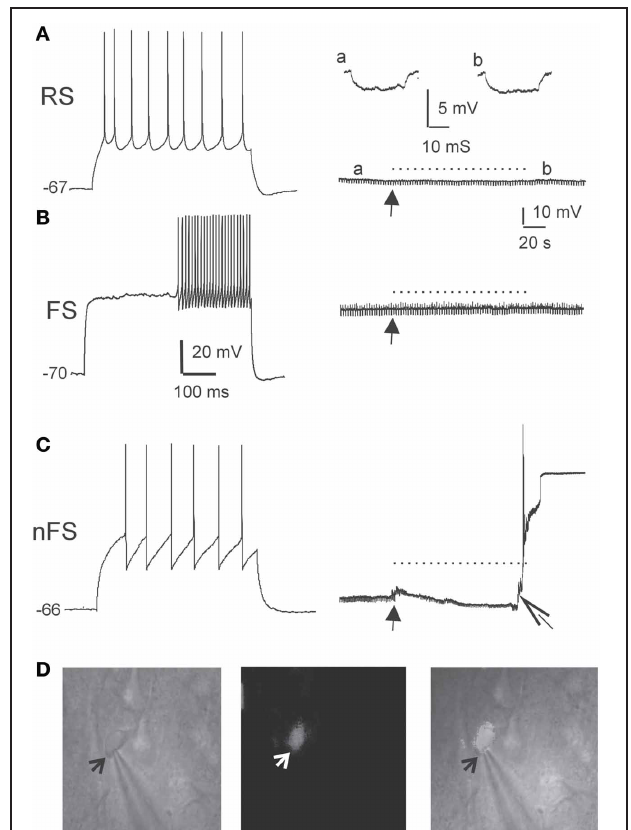
FIGURE 3 | DAF phototoxicity is selective to interneurons with LTS firing pattern. Layer 5 neurons were recorded in slices pre-incubated in DAF-2DA (2 μ M, 10min). (A) The left panel displays typical firing pattern of a pyramidal RS neuron in response to depolarizing current pulse. The resting potential is marked to the left. On the right—the recorded trace before opening the fluorescent shutter (arrow), during illumination (dotted line) and afterwards. A hyperpolarizing current pulse monitored the membrane resistance, and examples from time points “a” and “b” are displayed above. (B) Example traces of the response of a FS-type interneuron to light. Details as in (A) . (C) Example traces of the response of a LTS-type interneuron to light. Note on the right panel the appearance of instability of the membrane potential and a reduction of membrane resistance shortly after opening the shutter (closed arrow), and loss of the membrane potential shortly before the end of illumination (open arrow). (D) Images of the neuron in (C) . On the left is an IR/DIC image of the patched neuron. An arrow points to the tip of the recording pipette. The middle image shows the same field under fluorescent light, showing faint staining in the recorded neuron. On the right is a combined image.